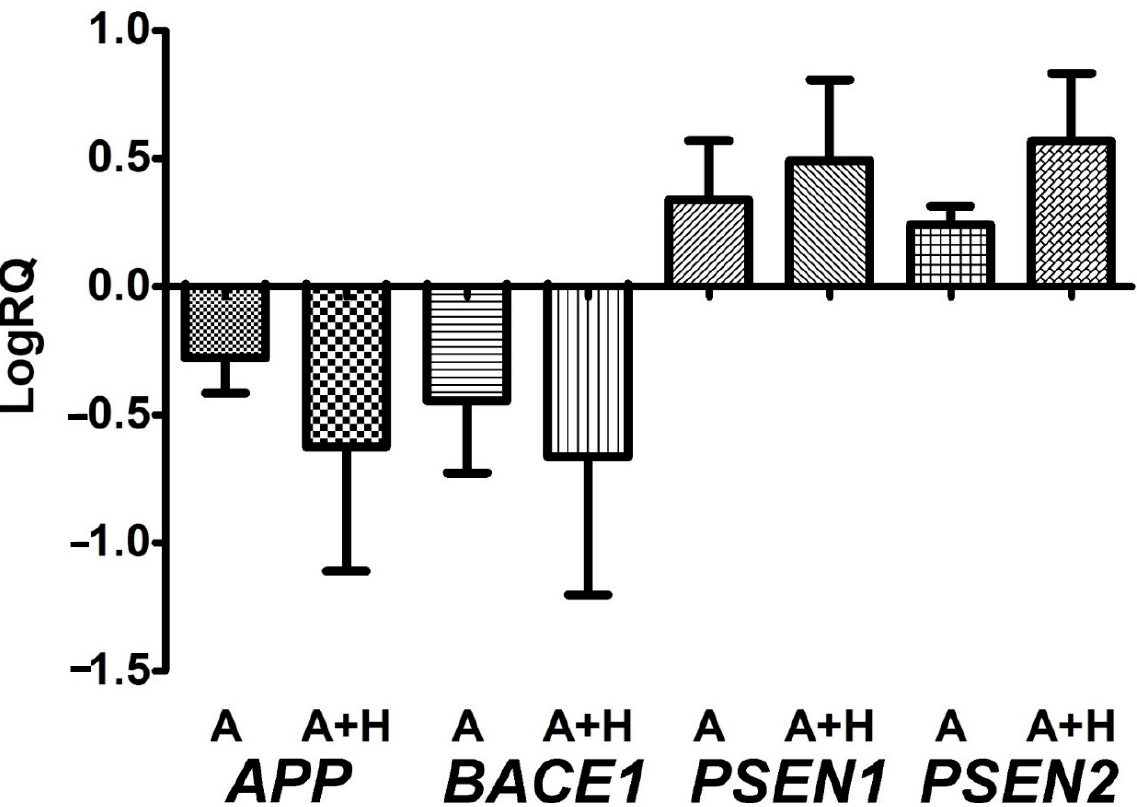
Figure 3. Mean levels of amyloid protein precursor (APP ), β -secretase ( BACE1 ), presenilin 1 ( PSEN1 ), and presenilin 2 ( PSEN2 ) gene expression in peripheral lymphocytes after perinatal asphyxia (A) and perinatal asphyxia with hypothermia (A + H) with survival of more than 15 days. Marked SD, standard deviation. The changes between the groups were not statistically significant (Mann-Whitney test).